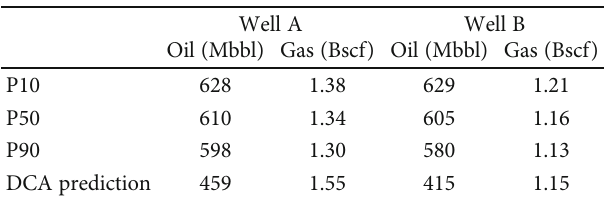
Figure 14: Histogram and cumulative distribution function of forecasting results: (a) well A oil production forecast, (b) well A gas production forecast, (c) well B oil production forecast, and (d) well B gas production forecast. Table 4: P10, P50, and P90 of the production forecast for the wells and comparison with DCA